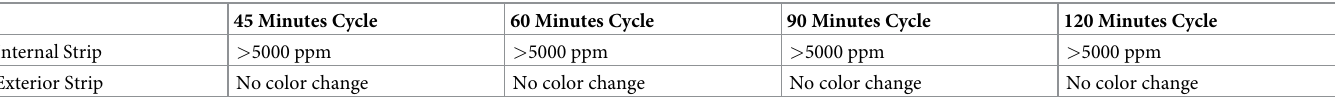
Table 3. Concentration strip results for 12% H 2 O 2 solution testing.